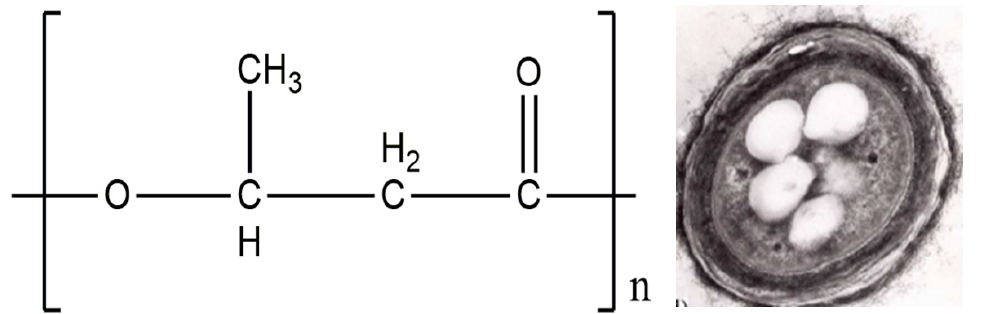
Figure 3. The formula of poly(3-hydroxybutyrate) and bacterial cell morphology of strain producer A. chroococcum during growth, reprinted with permission from [93].